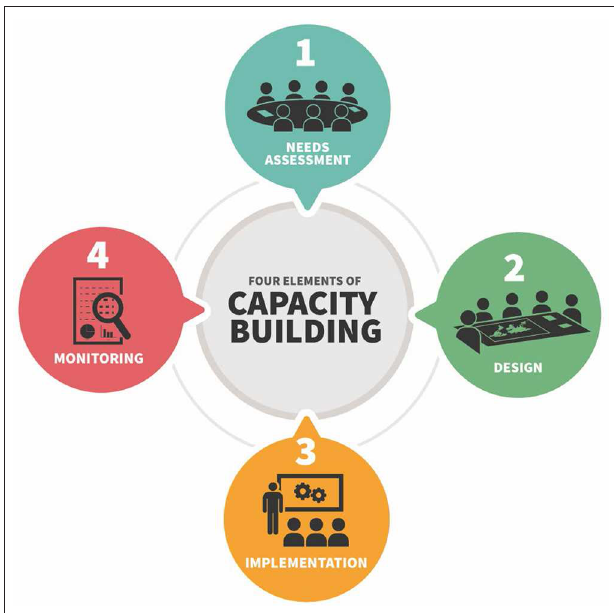
FIGURE 1 | ADIM—capacity building workflow.